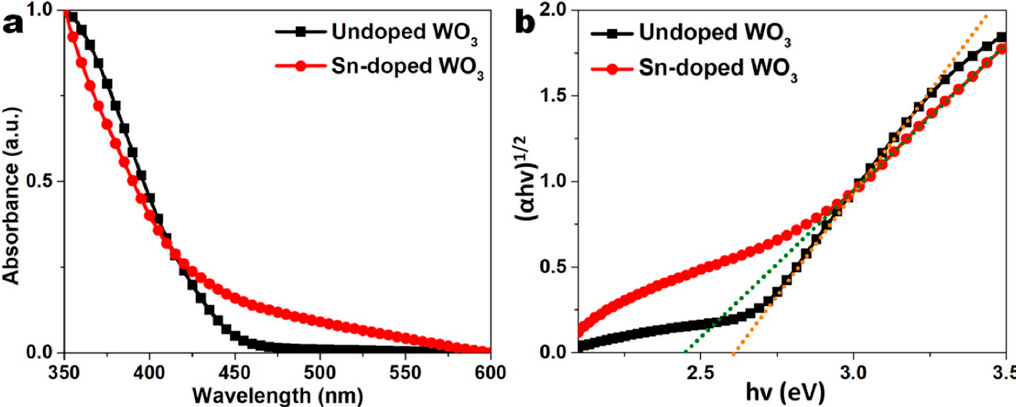
Figure 5. ( a ) UV–vis absorption spectra and ( b ) Tauc plot of undoped (black) and Sn-doped WO 3 (red) thin films.